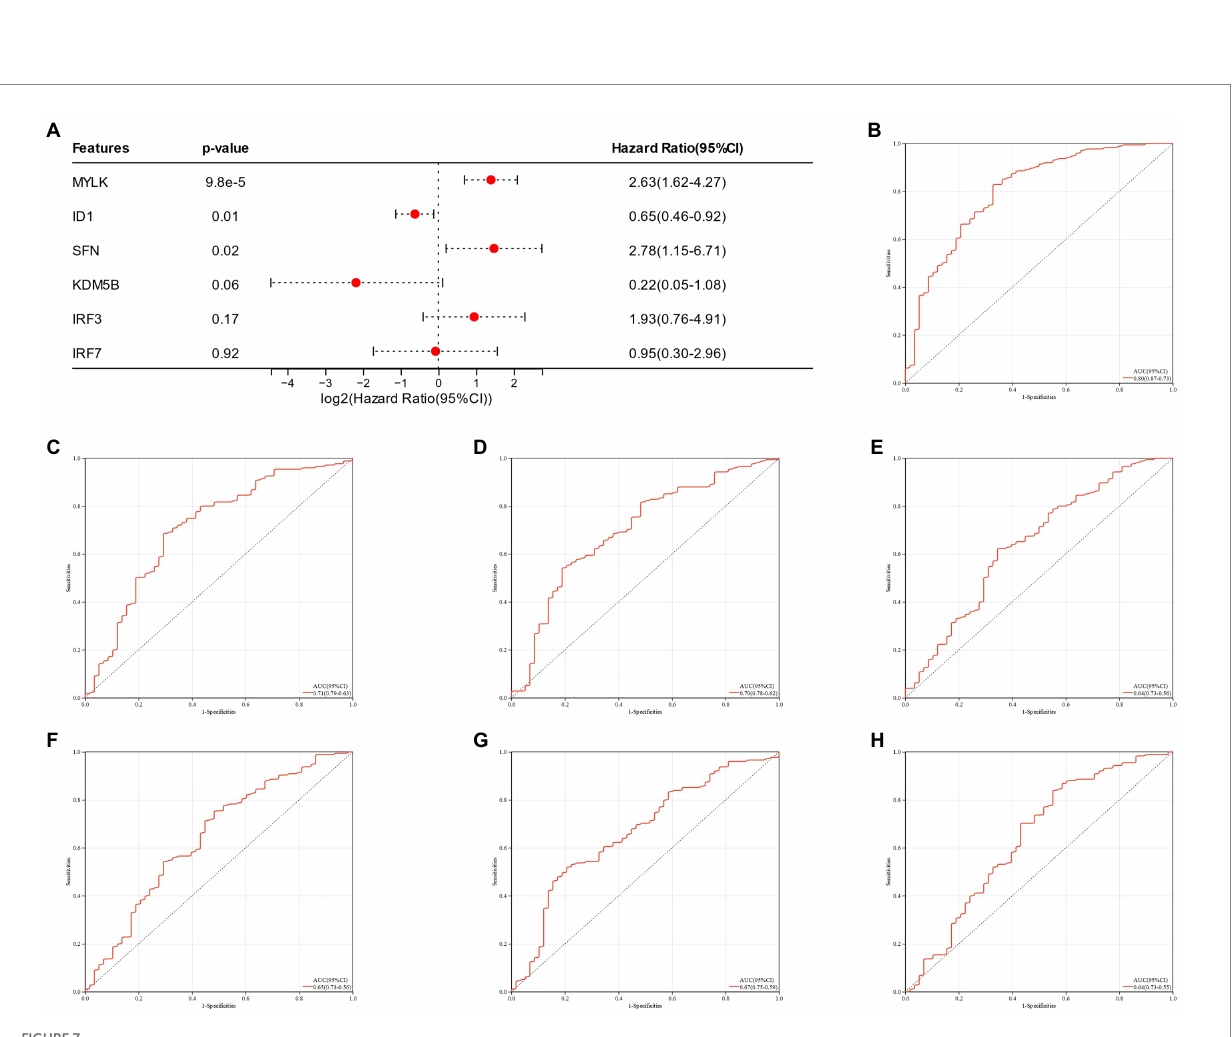
FIGURE 7 (A) Nomogram of candidate genes in the training group; (B–H) : Nomogram of the training group and ROC curves of candidate